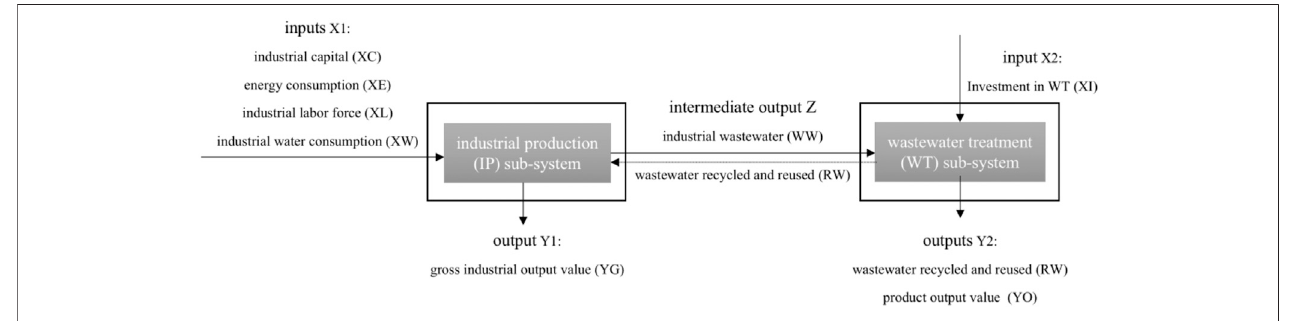
FIGURE 1 | Schematic of the IP and WT